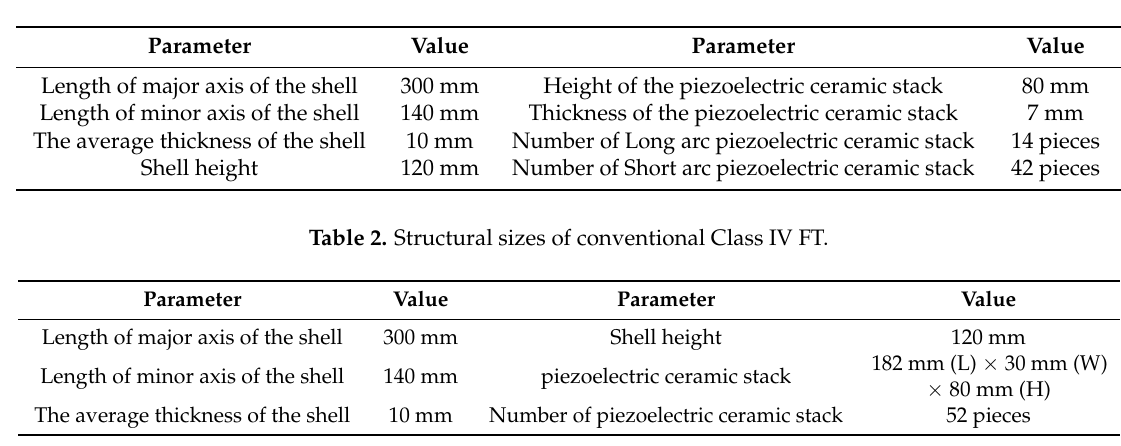
Table 1. Structural sizes of Conformal Driving Class IV FT.